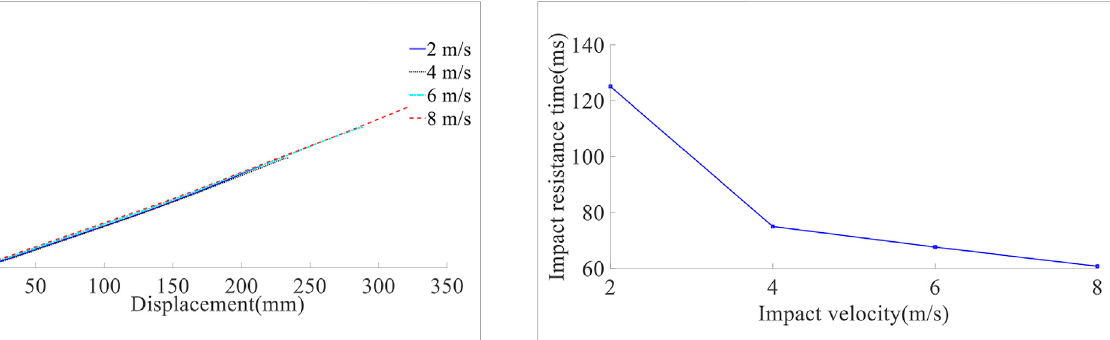
FIGURE 15 Anchor energy absorption-displacement curve.